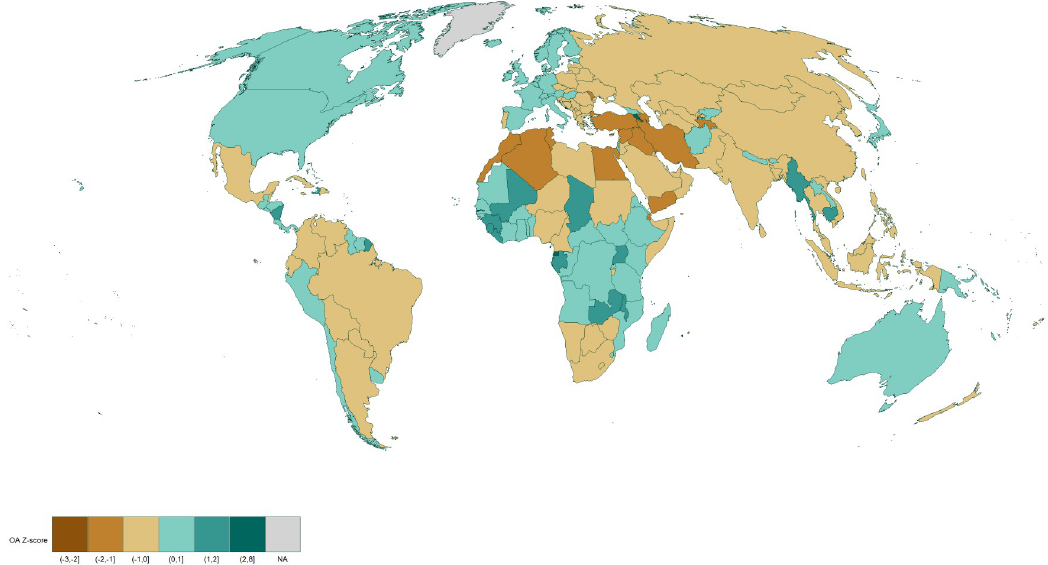
Fig 2. Weighted z-score and normalized map of references made to OA publications by country. Red indicates that a country above the world average, blue indicates it is below the world average. White represents the world average. Contains information from OpenStreetMap and OpenStreetMap Foundation, which is made available under the Open Database